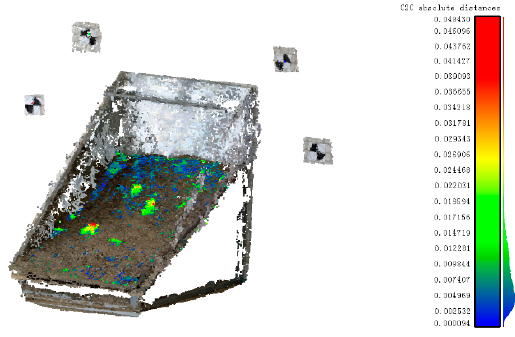
Figure 15. Rock mass surface deformation detection.